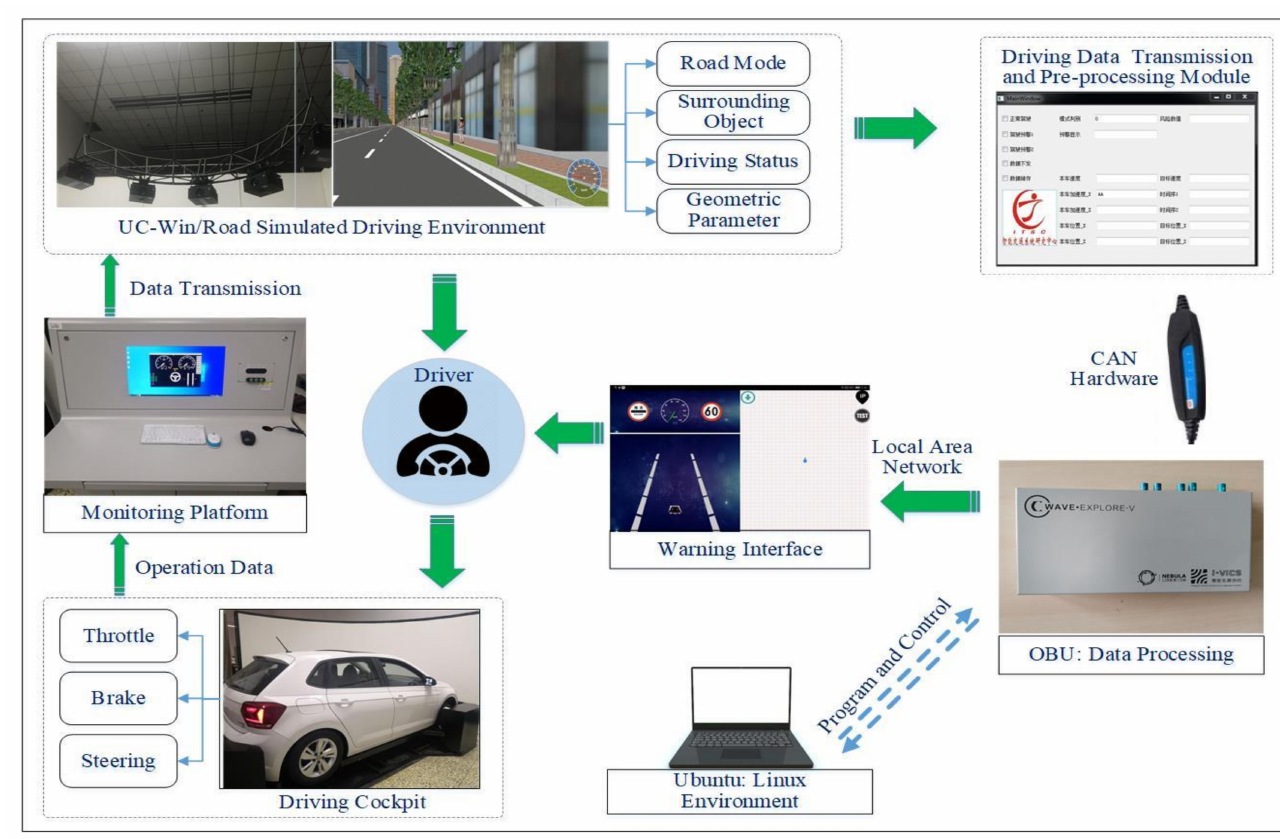
Figure 5. Test platform architecture of collision warning system based on V2I. UC-win/Road is a simulated driving software. CAN refers to controller area network. OBU refers to the on-board